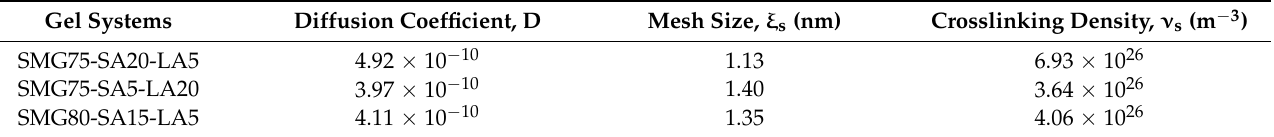
Figure 4. Dynamic Light Scattering analysis using SMILS of SMGs at 30 ◦ C ( a ) Scattering angle-dependence autocorrelation function and relaxation distribution function of SMG75-SA20-LA5 as a function of the relaxation time. ( b ) Scattering angle-dependence autocorrelation function and relaxation distribution function of SMG75-SA5-LA20 as a function of the relaxation time. Table 1. Internal network information of the SMGs.